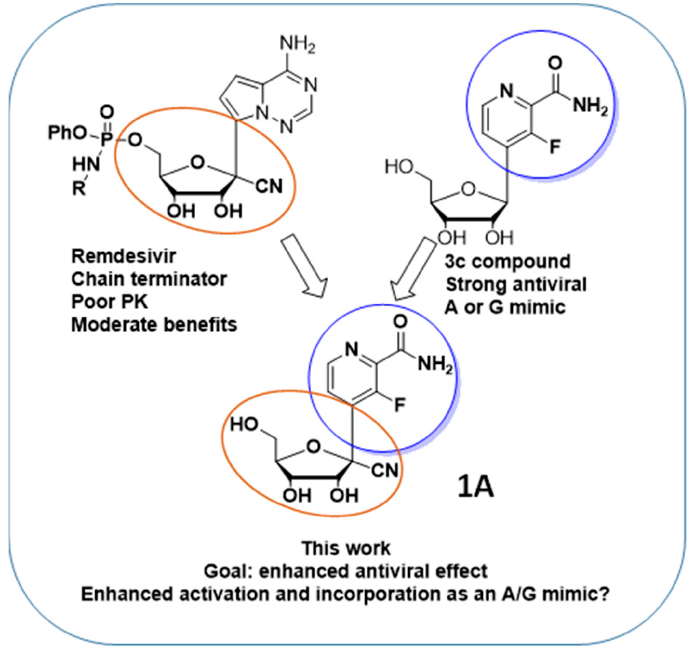
Figure 2. Enhanced Remdesivir analogue.